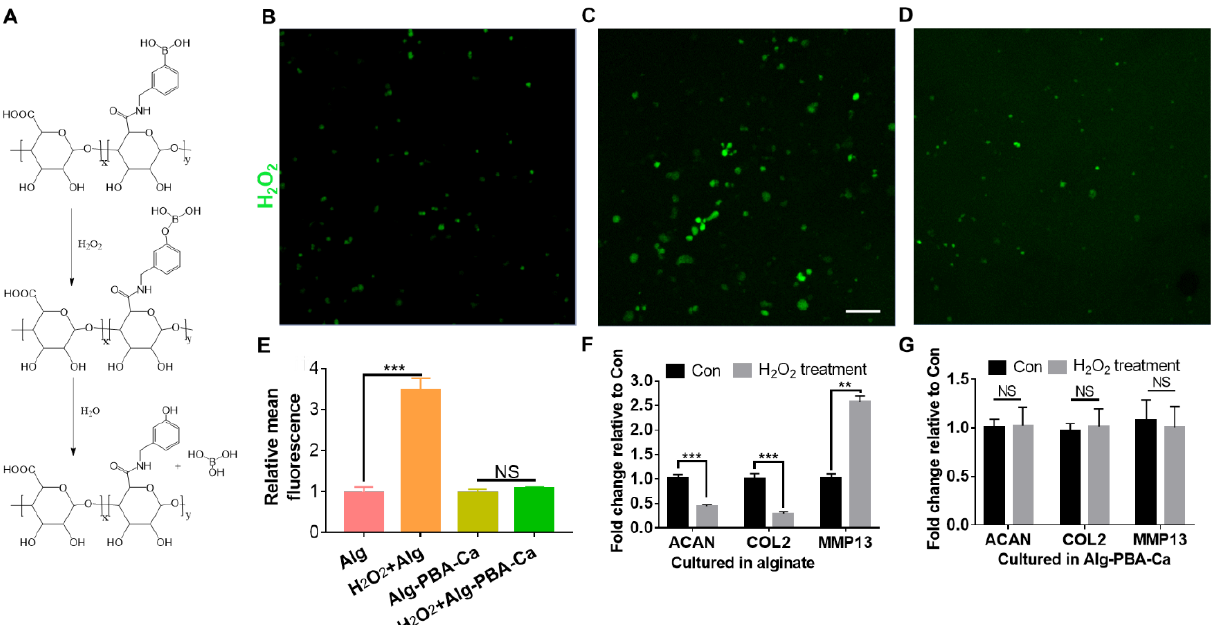
Figure 6. Characterization of anti-ROS property of the dynamic alginate hydrogel. ( A ) Mechanism behind the H 2 O 2 scavenging property of Alg-PBA. ( B – D ) ROS fluorescent staining of mouse chon- drocytes before H 2 O 2 exposure in the alginate hydrogel ( B ), after H 2 O 2 treatment in the alginate hydrogel ( C ), and with H 2 O 2 exposure in bioprinted Alg-PBA-Ca hydrogel ( D ). ( E ) Quantitative measurement of the intracellular ROS levels in different groups. ( F ) Mouse chondrocytes showed significant downregulation of two ECM anabolic genes (ACAN and COL2) and upregulation of one catabolic gene (MMP13) when cultured in alginate hydrogel after H 2 O 2 exposure. ( G ) Mouse chondrocyte showed no statistical difference in gene expression in three ECM genes when cultured in the bioprinted Alg-PBA-Ca hydrogel after H 2 O 2 exposure. Scale bar = 100 µ m. NS: not significant; ** p < 0.01; *** p <